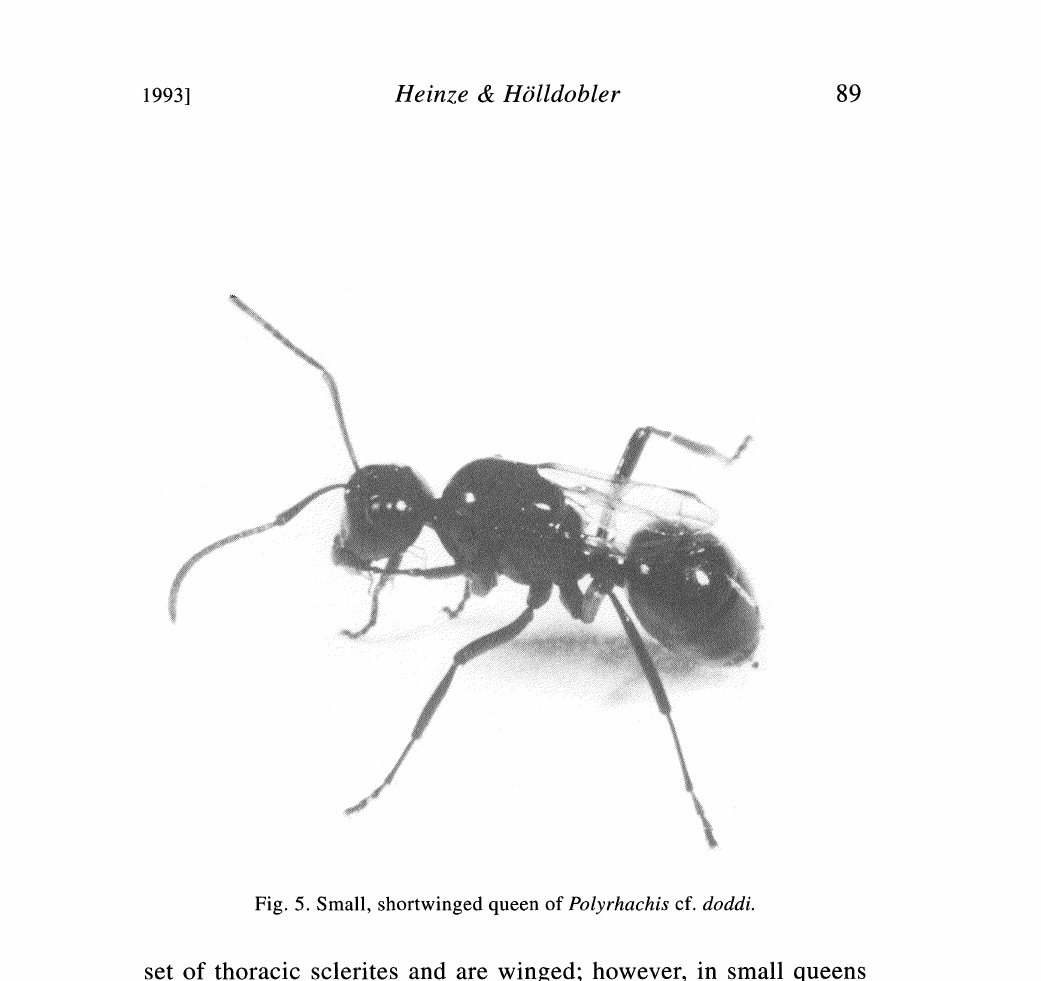
Fig. 5. Small, shortwinged queen of Polyrhachis cf.